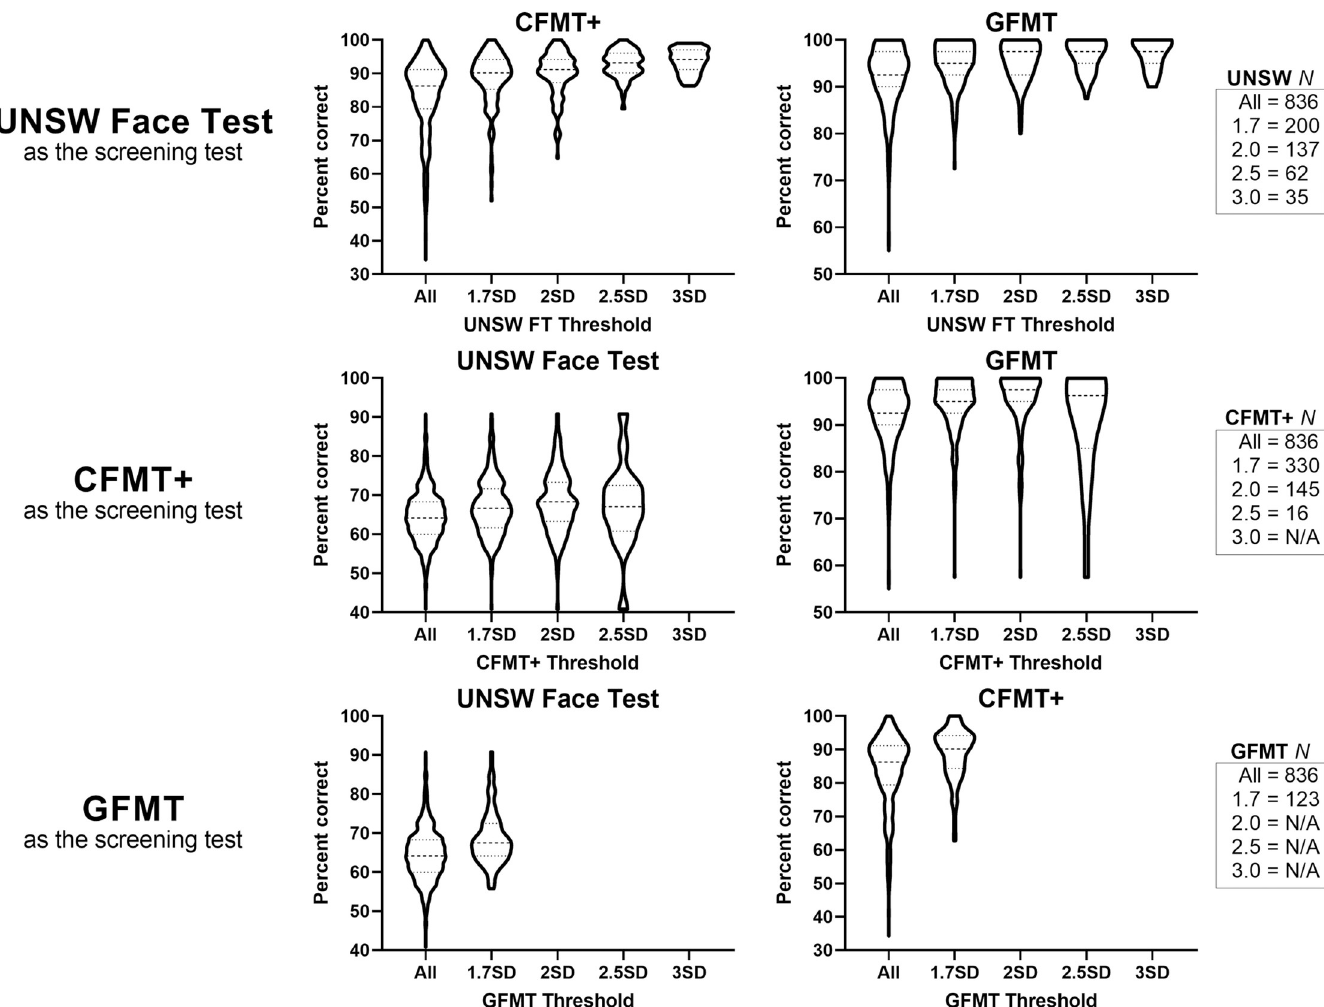
Fig 5. Violin plots show how the distribution of performance on each of the online tests varies as a function of the screening criteria. Each row shows the test used to select individuals (top row: UNSW Face Test; middle row: CFMT+; bottom row: GFMT). Boxes on the right show the number of participants in Online Sample 2 represented in each distribution. These data show that the ability to set stricter screening criteria on the UNSW Face Test provides greater precision for targeting high performing individuals to follow up testing than the CFMT+ or GFMT.